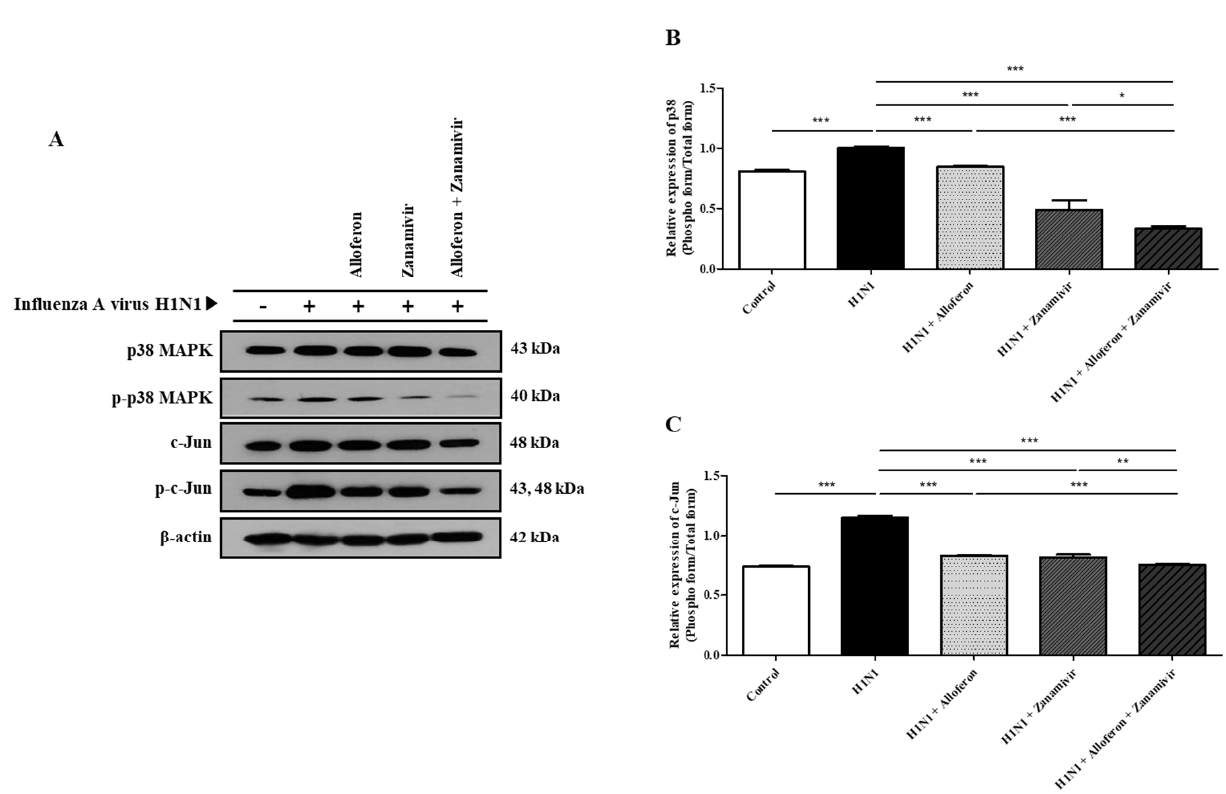
Figure 7. Combined treatment with alloferon (0.5 µ g/mL) and zanamivir (35 µ g/mL) inhibited H1N1-induced activation of the p38 MAPK and JNK signaling pathways in mouse lung tissue. ( A ) Lung tissues were collected after sacrifice, lysates were prepared in RIPA buffer, and western blot analysis was then performed for detection of p38 MAPK and JNK as described in the Section 4. Results are representative of more than three independent experiments. ( B , C ) Calculation of the relative intensity of the phospho form/total form was performed using Image J software. * p < 0.1 (The p < 0.1 statistical implications are results for determining tendency only), ** p < 0.01, *** p < 0.001, NS; no significant.